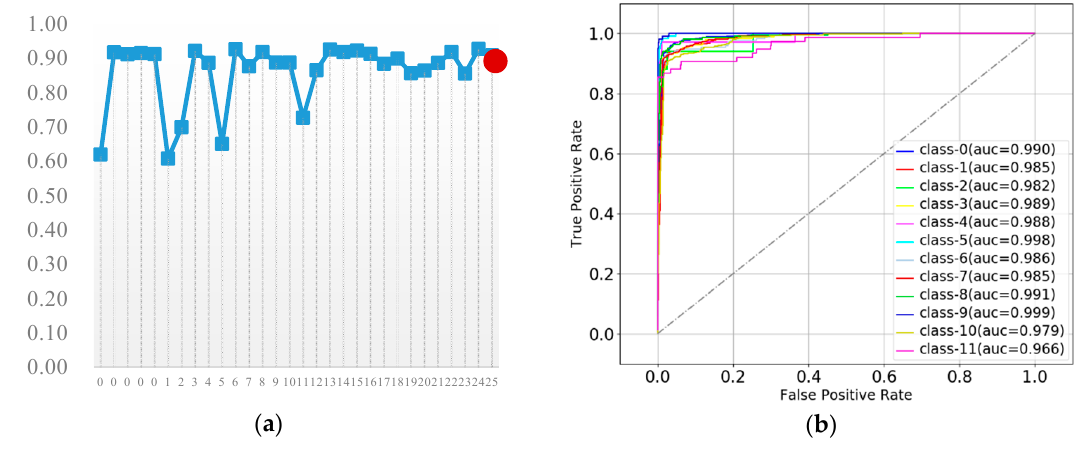
Figure 14. Parameter Tuning Process and ROC of XGBoost, where ( a ) Description of the parameter tuning process of XGboost, where y -axis is ACC and x -axis is iteration; ( b ) ROC of XGBoost. Table 15. Parameter Tuning Process of XGBoost Classifier.